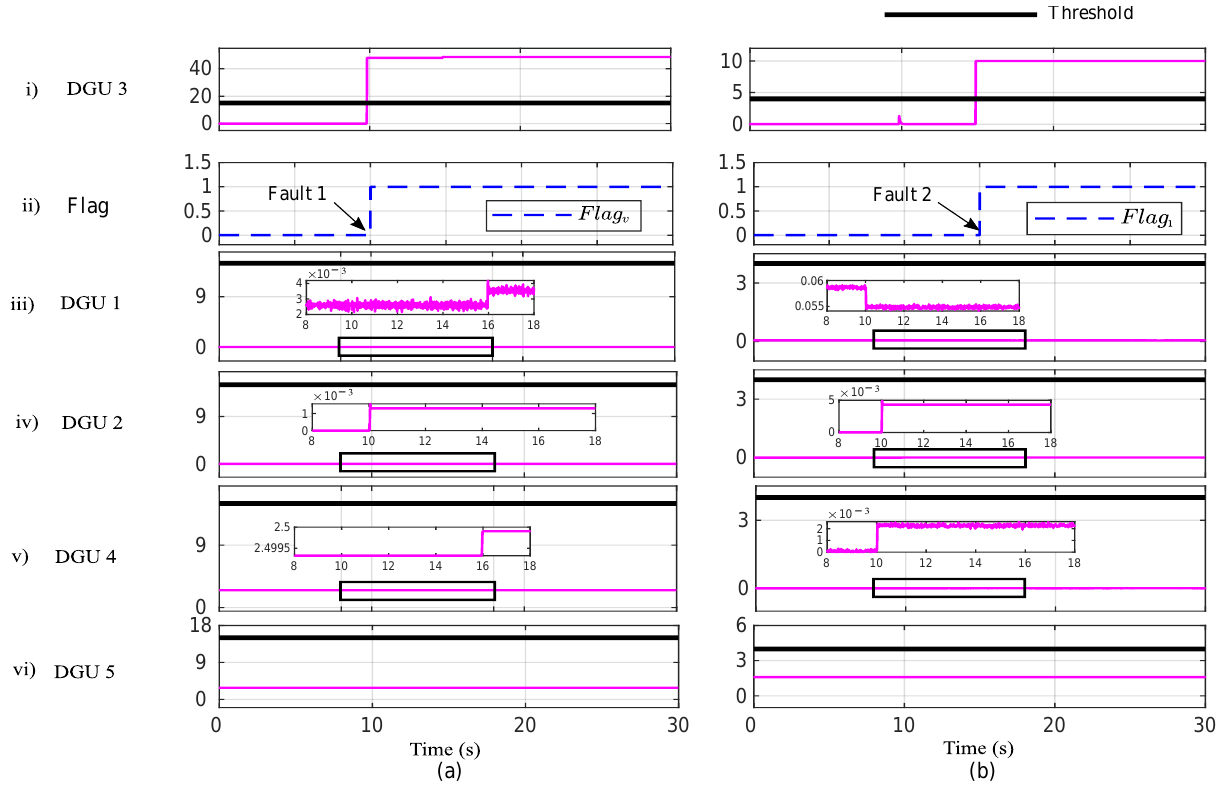
Figure 8. Residuals of the DGUs during voltage and current sensor fault in DGU 3. ( a ) Voltage residuals of the DGUs; ( b ) Current residuals of the DGUs.